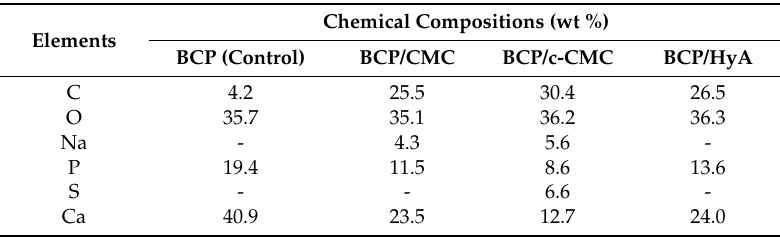
Table 1. Energy dispersive X-ray spectroscopy (EDX) determined chemical compositions (wt %) in the four study groups.